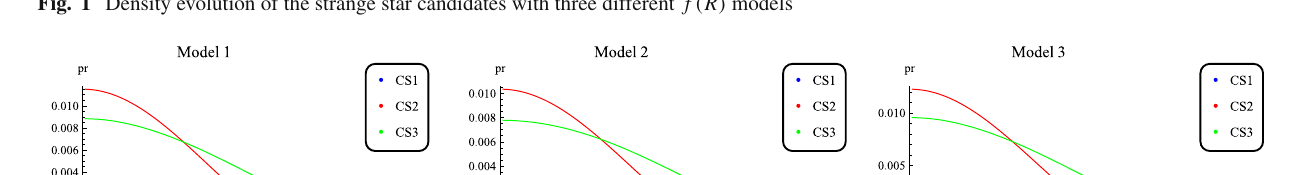
Fig. 1 Density evolution of the strange star candidates with three different f ( R ) models